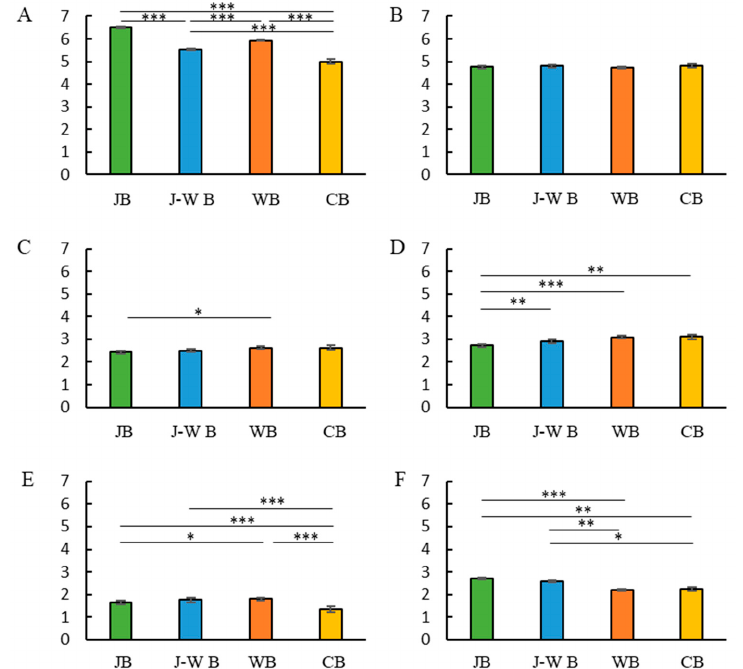
Figure 2. Breakfast style and usual food score. Breakfast style and staple food score ( A ). Breakfast style and vegetable score ( B ). Breakfast style and fruits score ( C ). Breakfast style and snack score ( D ). Breakfast style and juice score ( E ). Breakfast style and alcohol score ( F ). * p < 0.05, ** p < 0.005, *** p < 0.001 (Dunn’s test).